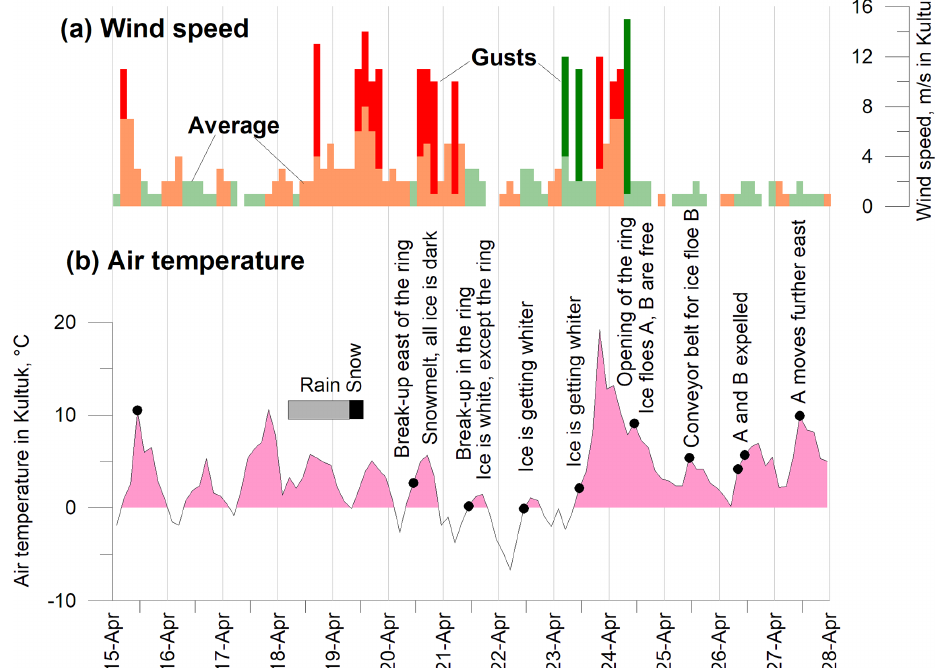
Figure 6. Temporal changes of (a) wind and (b) air temperature for 15–28 April 2020 at the Kultuk meteorological station (Russian Hy- drometeorological Service). The period is selected to represent meteorological conditions for satellite imagery presented in the paper. Wind speed is coloured as a function of the general direction. Wind coming from the Tunka Valley ( kultuk wind) was classed as wind coming from the direction 292.5 ◦ (WNW, main direction of the opening of the valley) with a ± 45 ◦ span: 247.5 to 337.5 ◦ , or wind between WSW and NNW. Kultuk wind is coloured in peach/red; winds from all other directions are in light/dark green. For each of the two directions we also present two different estimates of wind speed: average wind speed (lighter colour) and maximal gusts (darker colour). Black circles on the air temperature graph shows the date and time of satellite images discussed in the